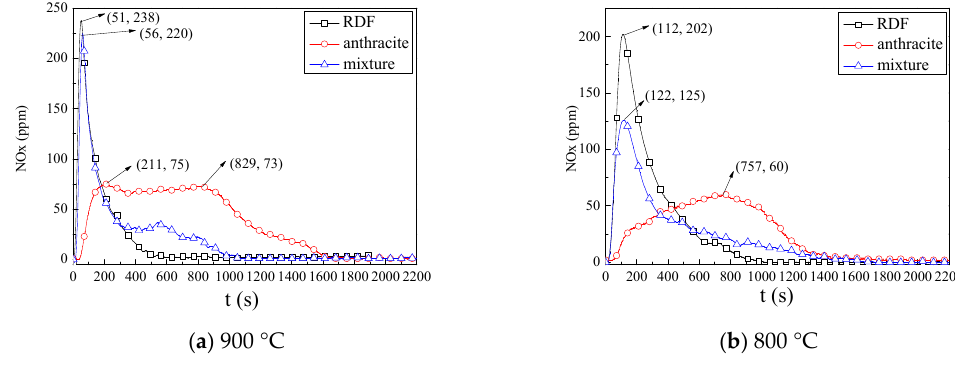
Figure 6. NOx emission curves at different temperatures.